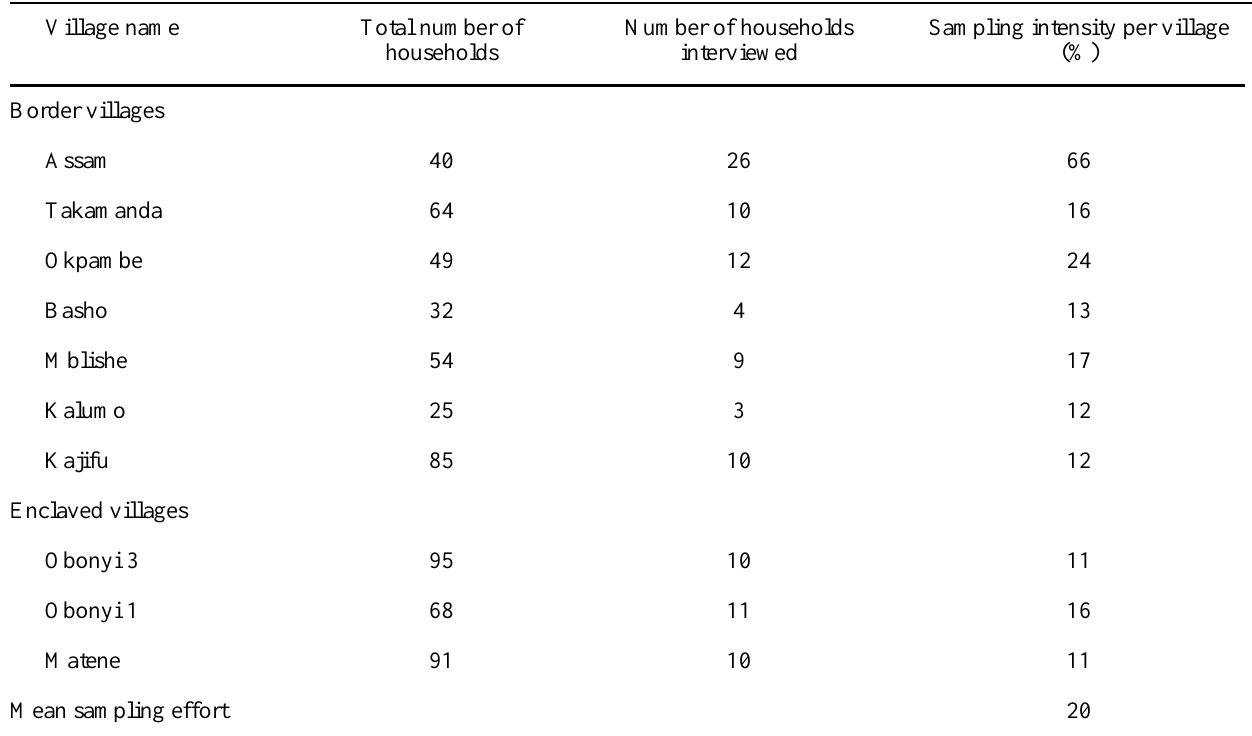
Table 1. Sampling effort for farmer interviews in villages bordering, or enclaved within, Takamanda National